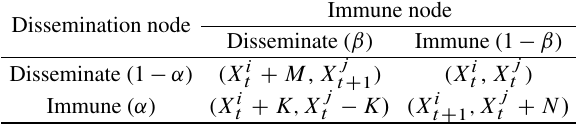
Table 1 Payoff matrix of dissemination and immune